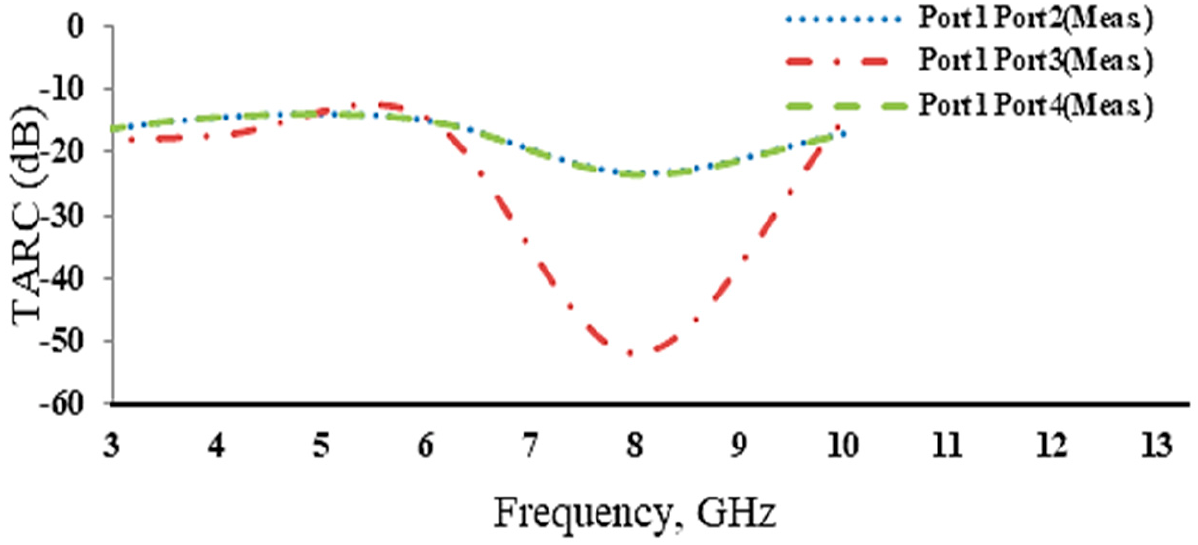
Figure 10. Measured total active reflection coefficient (TARC) of the proposed MIMO antenna